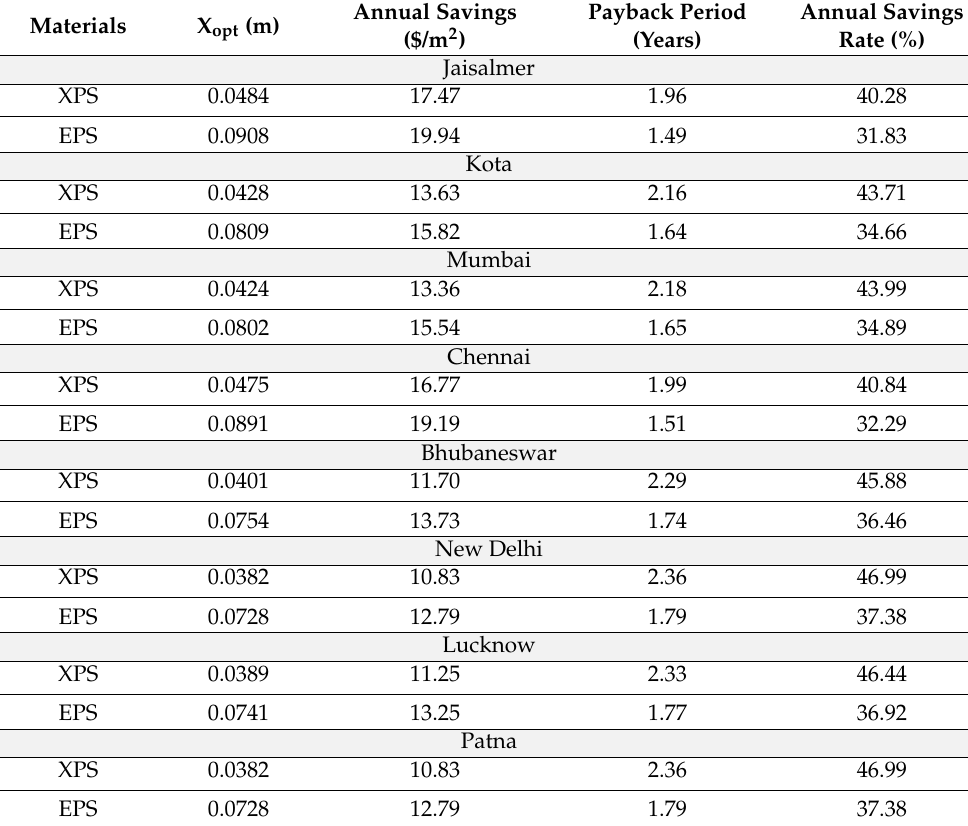
Table 4. Results of various insulation materials for cooling.